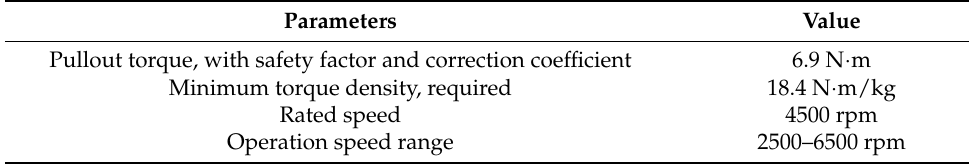
Table 1. Design parameters.